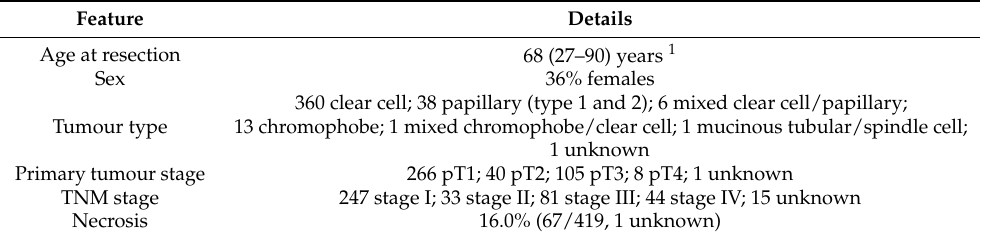
Table 1. Patient cohort with histological tumour